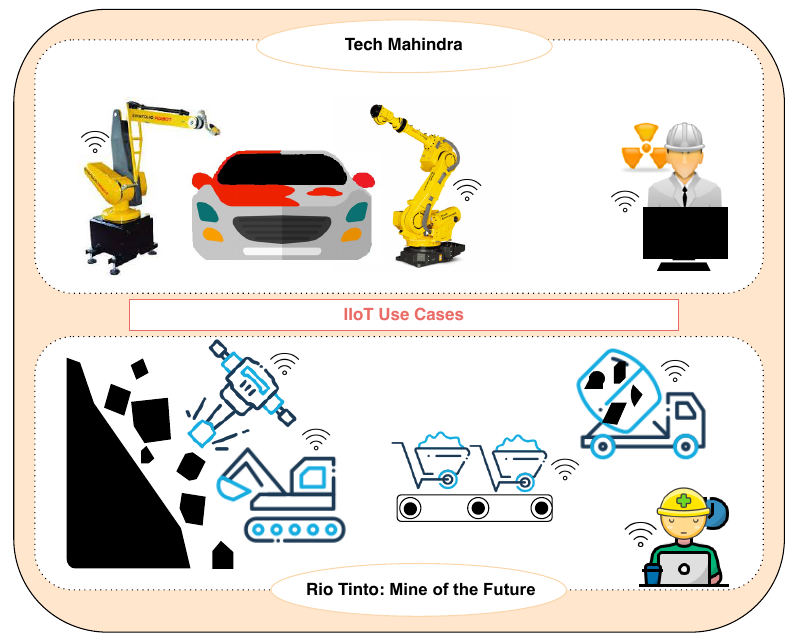
Figure 2. Few use cases of